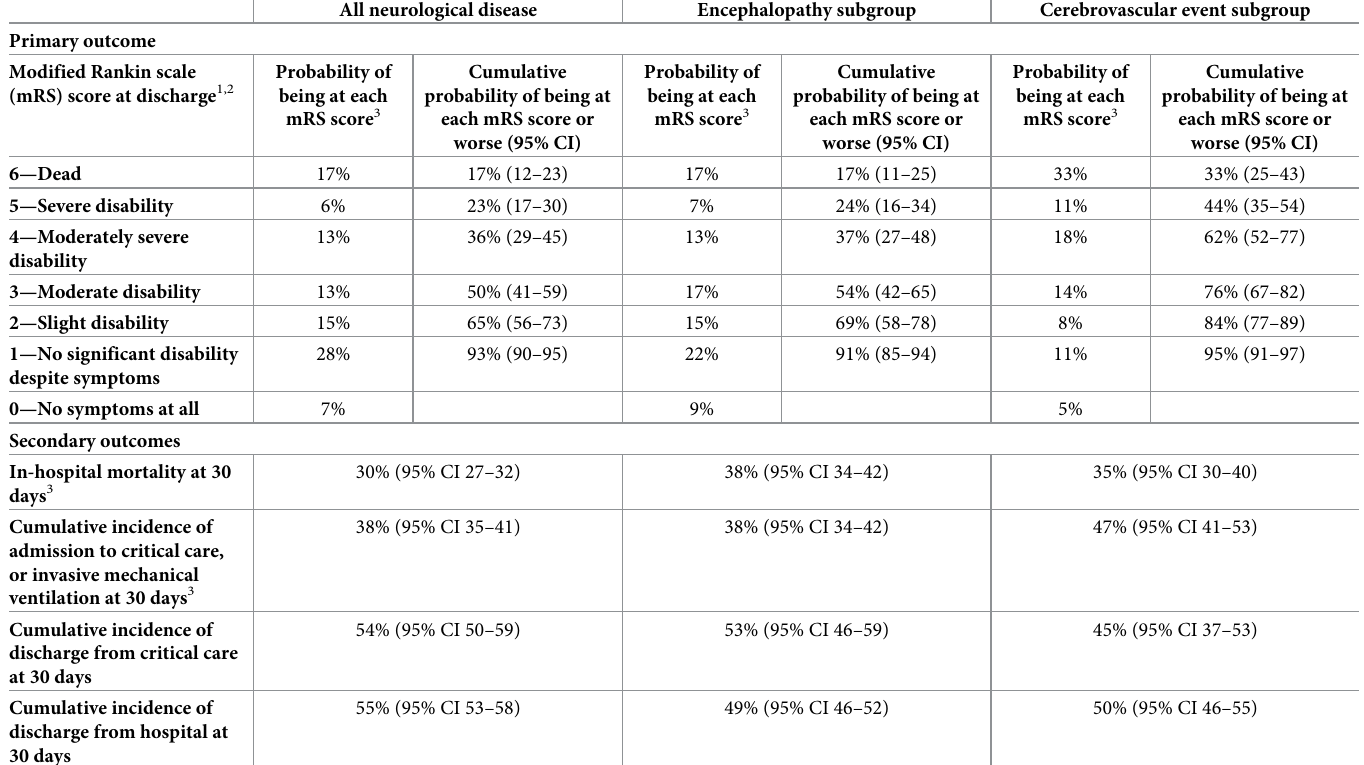
Table 2. Outcomes—Modified Rankin scale score at discharge, mortality, and need for intensive care—For patients with individual patient data with any neurologi- cal disease, and for those with cerebrovascular events and encephalopathy. All neurological disease Encephalopathy